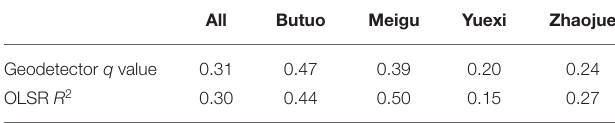
TABLE 2 | Asymmetry of spatial distribution between recent and long-term infection cases. All Butuo Meigu Yuexi Zhaojue Geodetector q value 0.31 0.47 0.39 0.20 0.24 OLSR R 2 0.30 0.44 0.50 0.15